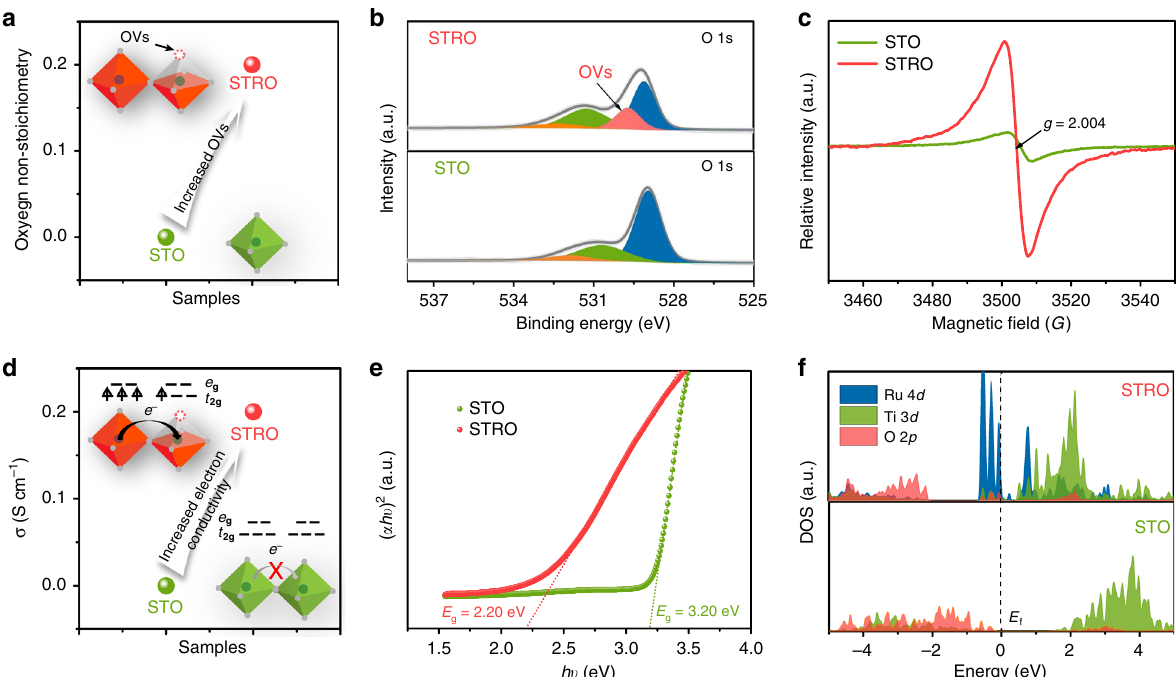
Fig. 5 Enhanced oxygen vacancy and electrical conductivity. a The oxygen non-stoichiometry of STO and STRO. b O 1 s XPS spectra of STO and STRO. c EPR spectra of STO and STRO. d The electronic conductivity of STO and STRO at room temperature. e Tauc plots of UV – vis spectroscopy for STO and STRO. f DOS pro fi les of STO and